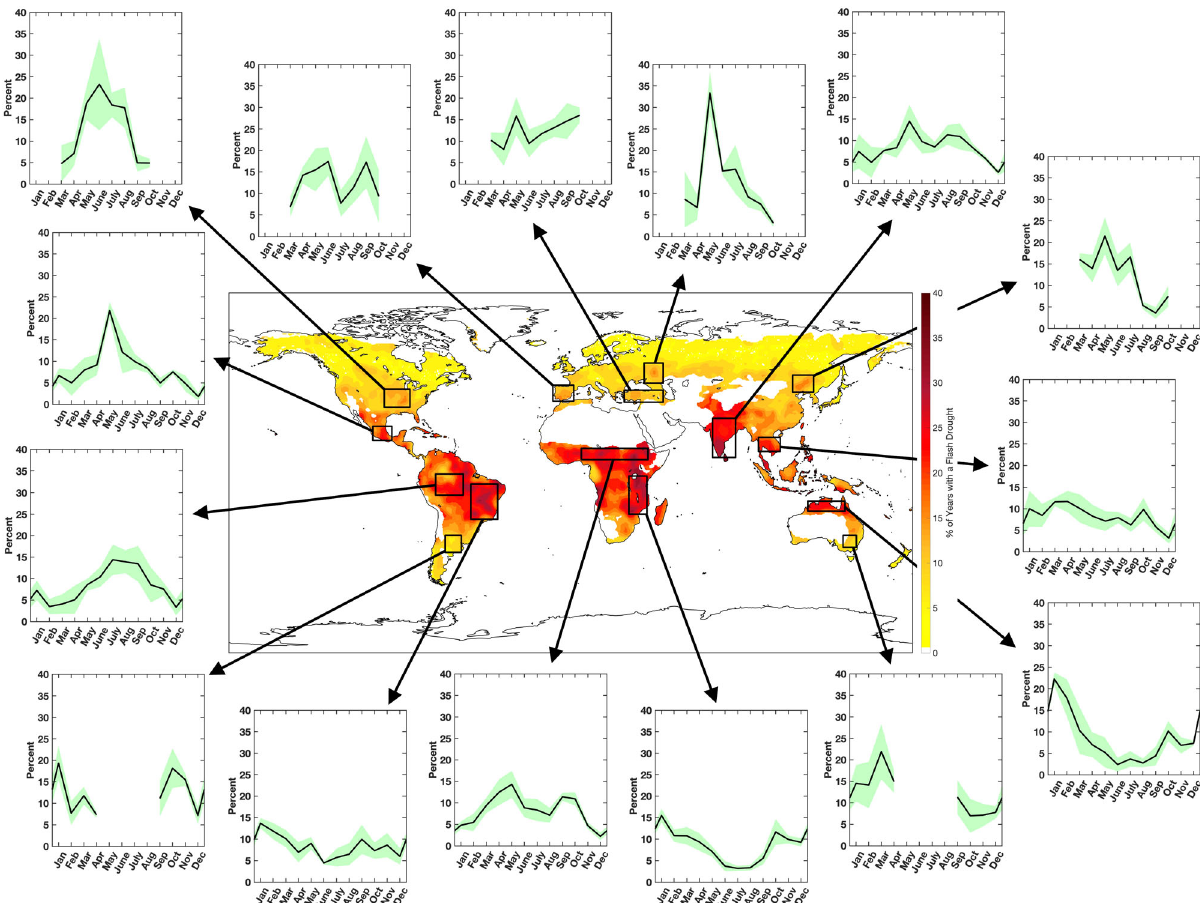
Fig. 2 Monthly fl ash drought occurrence. Monthly distribution of mean fl ash drought occurrence from the four reanalysis data sets (black line) for each domain outlined in black on the map. The green shaded area represents the variability (standard deviation) between the four